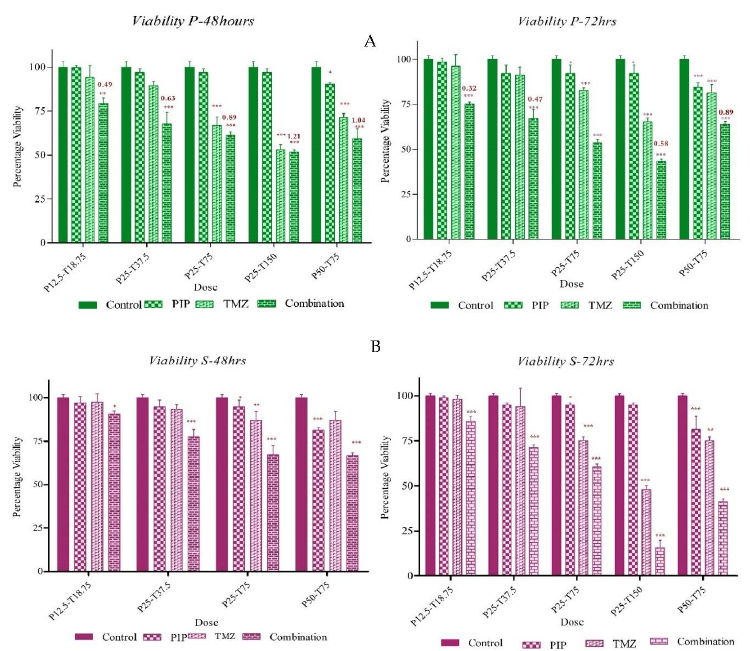
Figure 12. The effect of survivin inhibition on P and S cells. The effect on the efficacy of TMZ. ( A ) The percentage viability with single and combination drugs for 48 and 72 h for P and ( B ) for S cells. The CI values are indicated above the graph of P cells. The graphical data are presented as mean ± SD, and the statistical analysis was performed using one ‐ way ANOVA (*: p ‐ value < 0.05; **: p ‐ value < 0.01; ***: p ‐ value < 0.001).